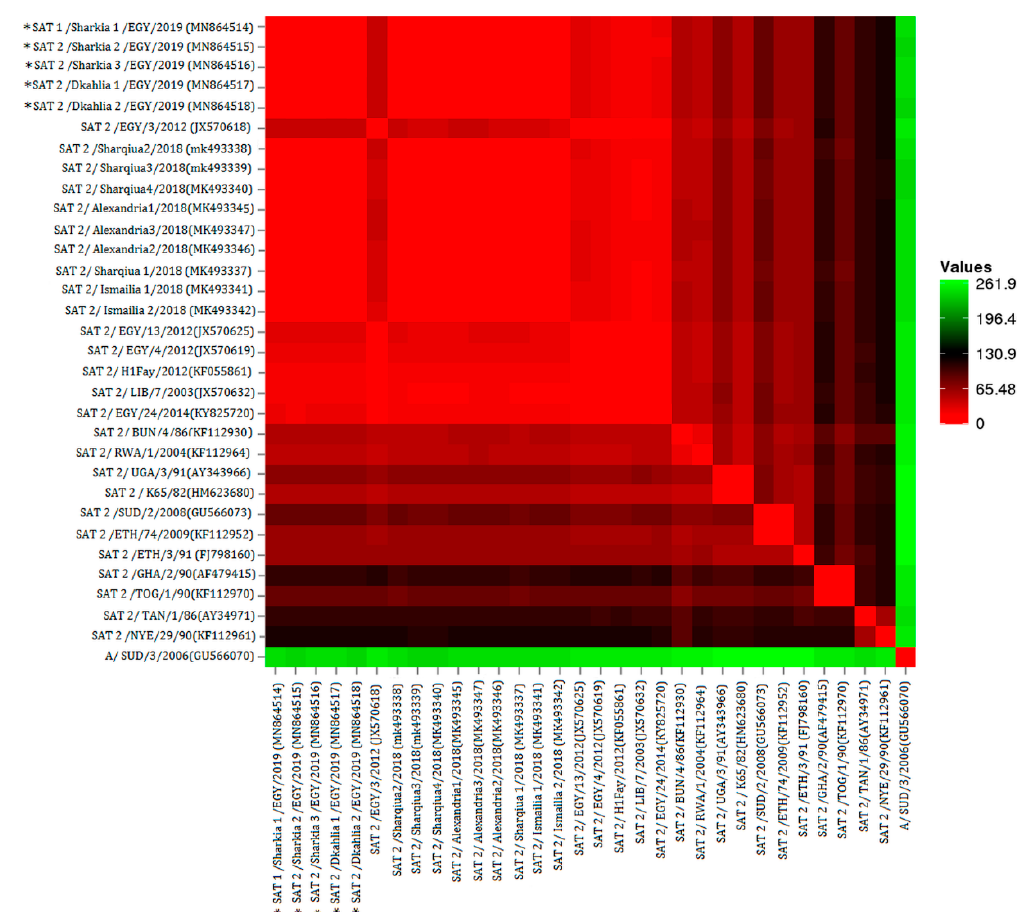
Figure 2. The pairwise distance among the studied FMD isolates. The Euclidean distance was calculated based on the VP1-coding sequences and is shown as colours. The colour key represents the Euclidean distance. The (*) refers to the FMD isolates recovered in the present study.